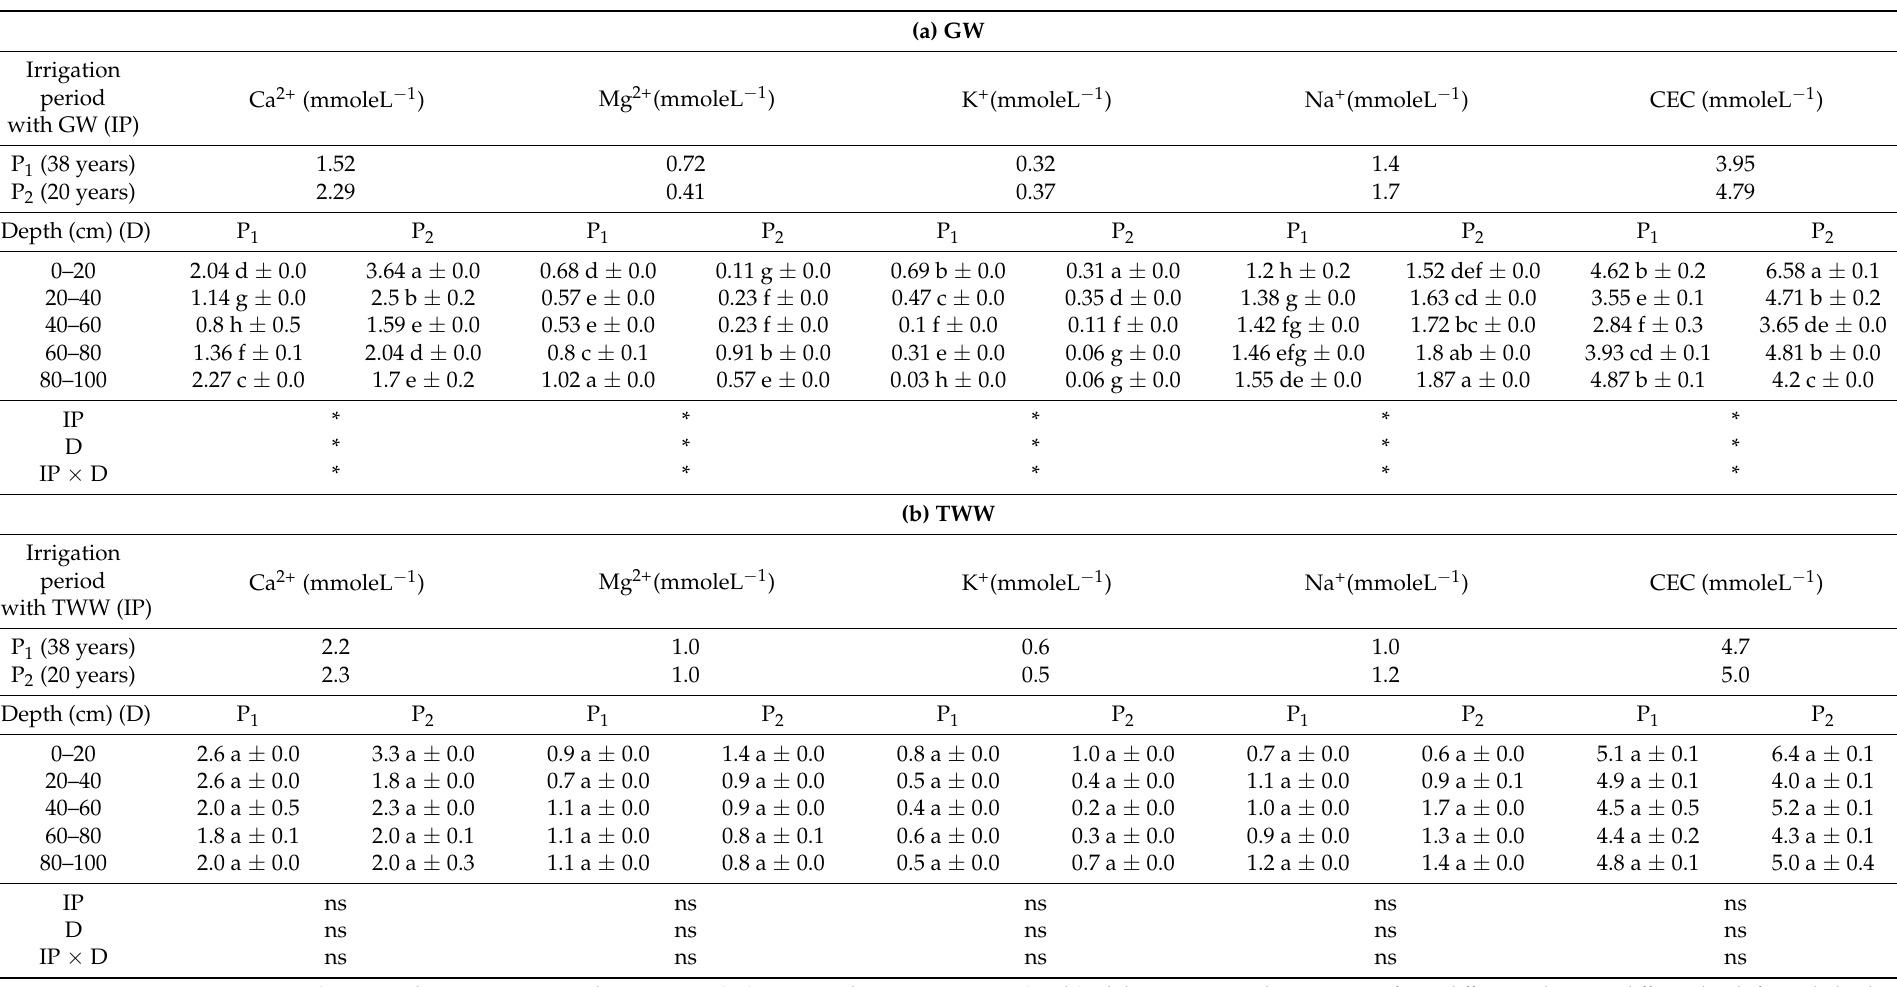
Table 5. Changes in soil Ca 2+ , Mg 2+ , K + , and Na + concentrations and CEC according to depth and irrigation period with GW (a) and TWW (b) in P 1 and P 2 areas. (a)